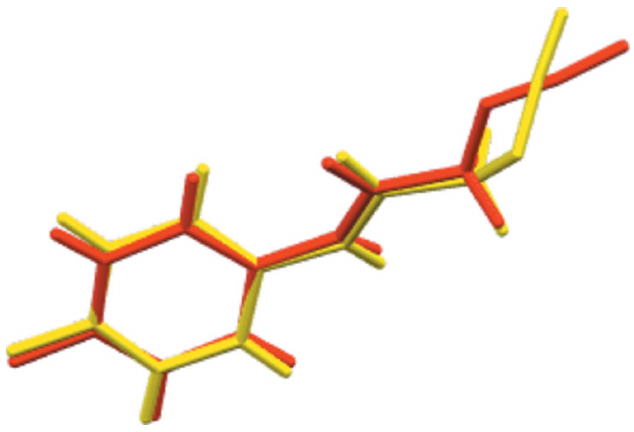
Figure 2 Overlay of the two molecules in the asymmetric unit. The yellow molecule contains O1 while the red one contains O2.